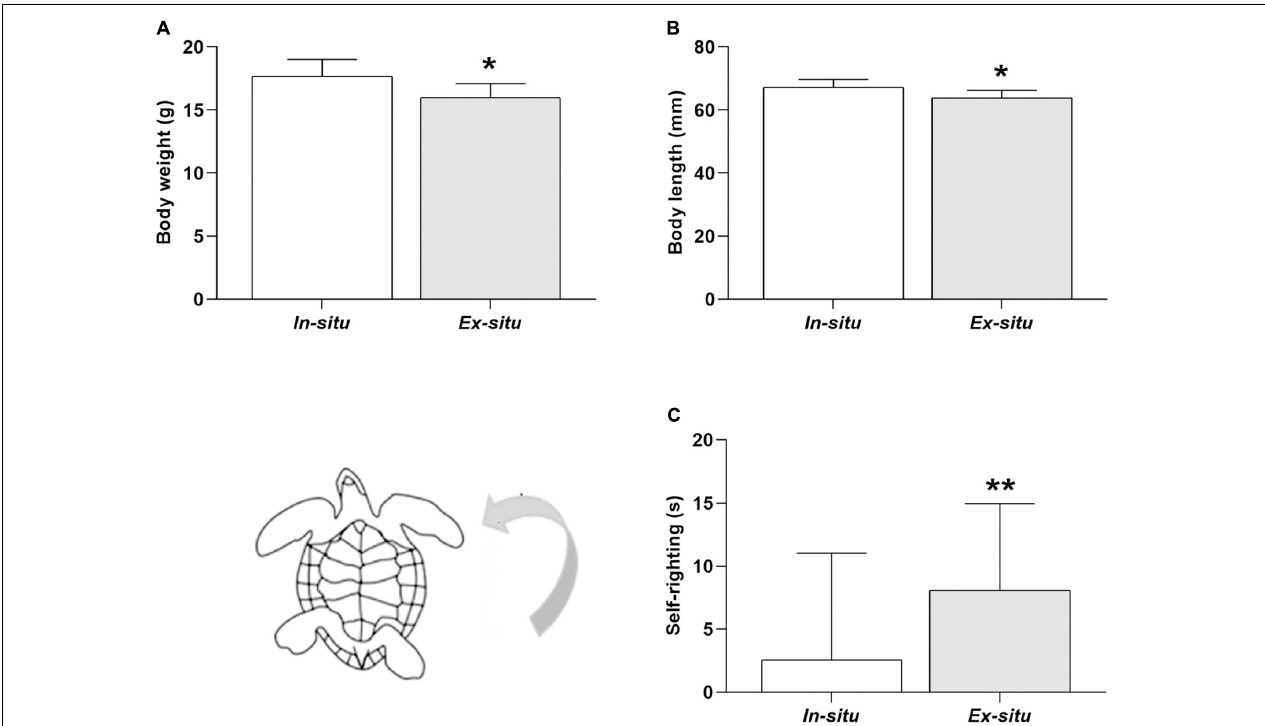
FIGURE 6 | Body size and self-righting time of L. olivacea hatchlings. (A) Graph showing body mass. (B) Graph of body length. (C) Graph of self-righting time. In situ ( n = 5), ex situ ( n = 5). Mean ± SD, Type III Analysis of Variance * p ≤ 0.05, ** p ≤